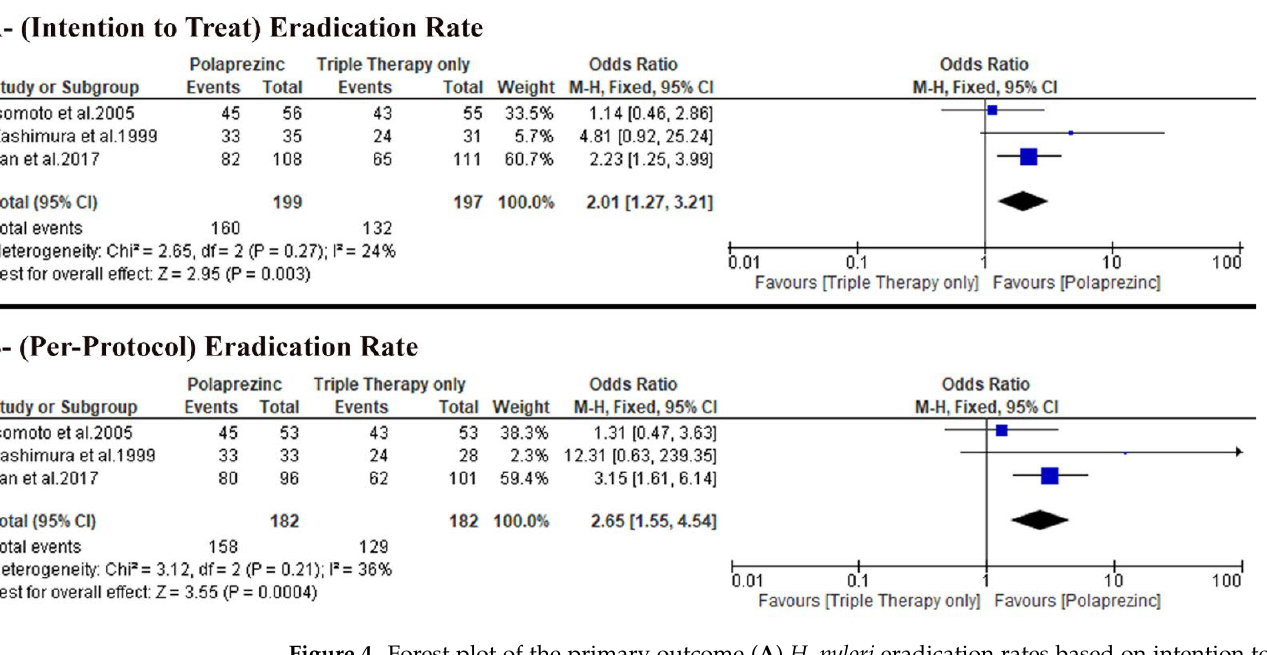
Figure 4. Forest plot of the primary outcome ( A ) H. pylori eradication rates based on intention to treat analysis, ( B ) H. pylori eradication rate based on per protocol analysis [50]. OR: odds ratio, CI: confidence interval.